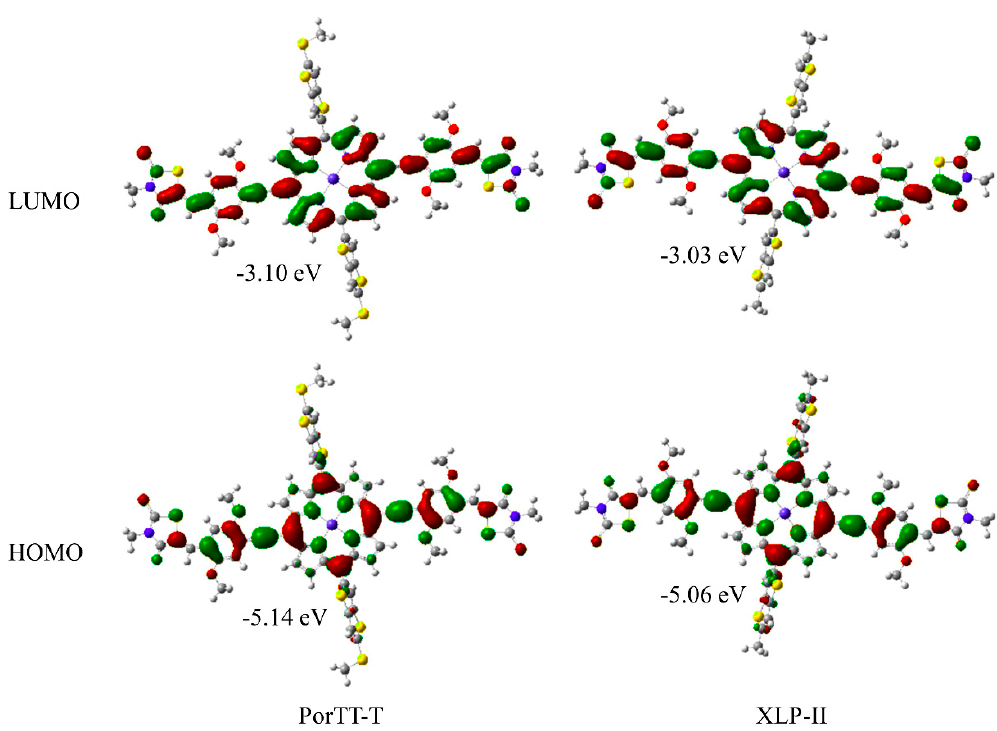
Figure 3. Frontier molecular orbitals of PorTT-T and XLP-II obtained by DFT calculations.